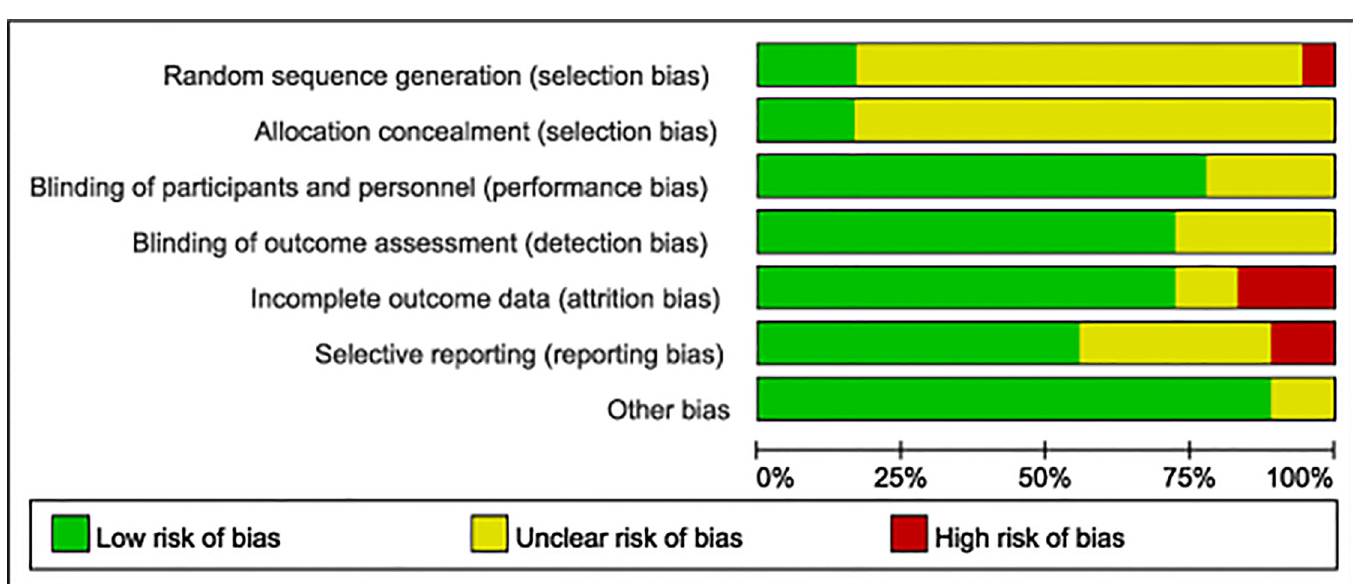
Fig 2. Risk-of-bias graph. The review of judgments of authors about each risk-of-bias item is presented as percentages across all included